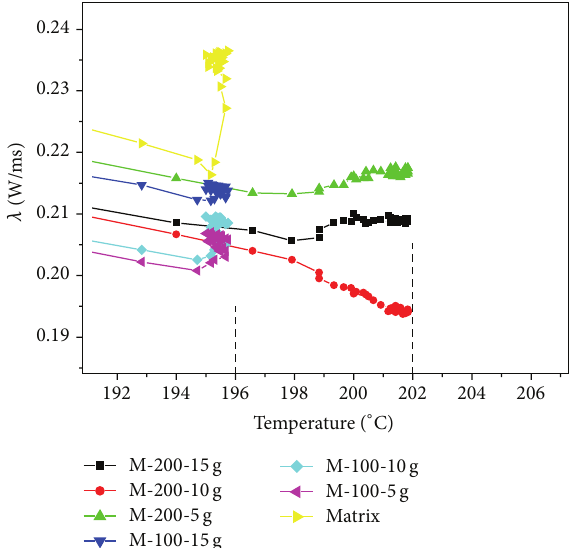
Figure 4: Thermal conductivity of composite materials with two sizes (M-100 and M-200) and three concentrations (15, 10, and 5 g) in the range of 194–202 ∘